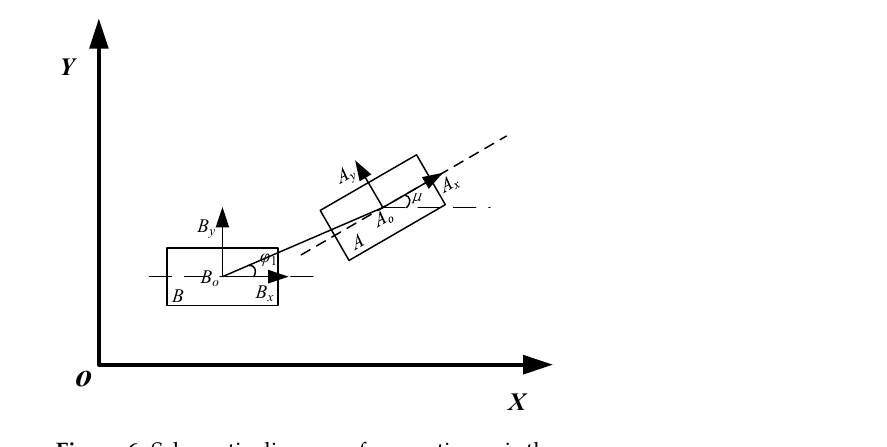
Figure 6. Schematic diagram of separating axis theorem.